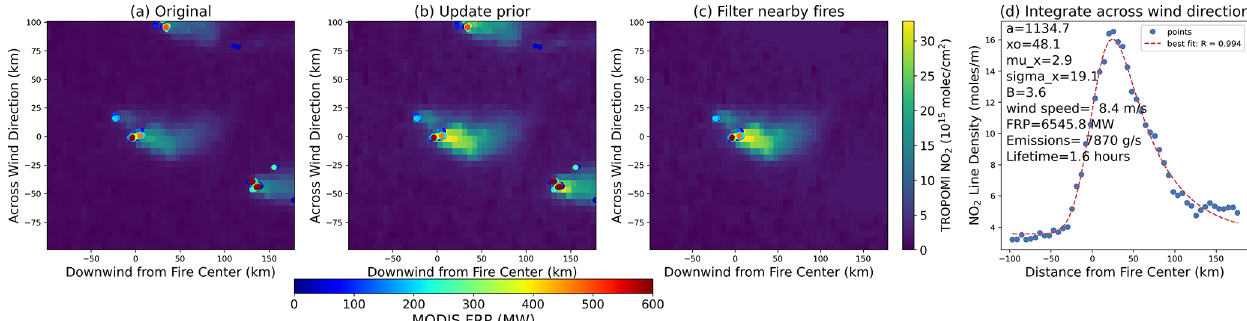
Figure 2. An example fire event illustrating four steps to estimate NO x emissions and lifetime using the EMG approach: (a) original TROPOMI-retrieved NO 2 tropospheric vertical column density rotated to align with the wind direction; (b) retrieved NO 2 column density after replacing the a priori vertical profile of NO 2 from NASA GEOS-CF simulation; (c) central fire plume after filtering the nearby fire plumes; and (d) NO 2 line density calculated by integrating NO 2 column density across the wind direction. The red line in panel (d) shows the fitted line density using the EMG function (Eq. 7). The lifetime is estimated from Eq. (8), and the total NO x emissions are estimated using Eq. (9). FRP is calculated as the sum of the FRP of all fire pixels detected by MODIS shown in panel (c) .